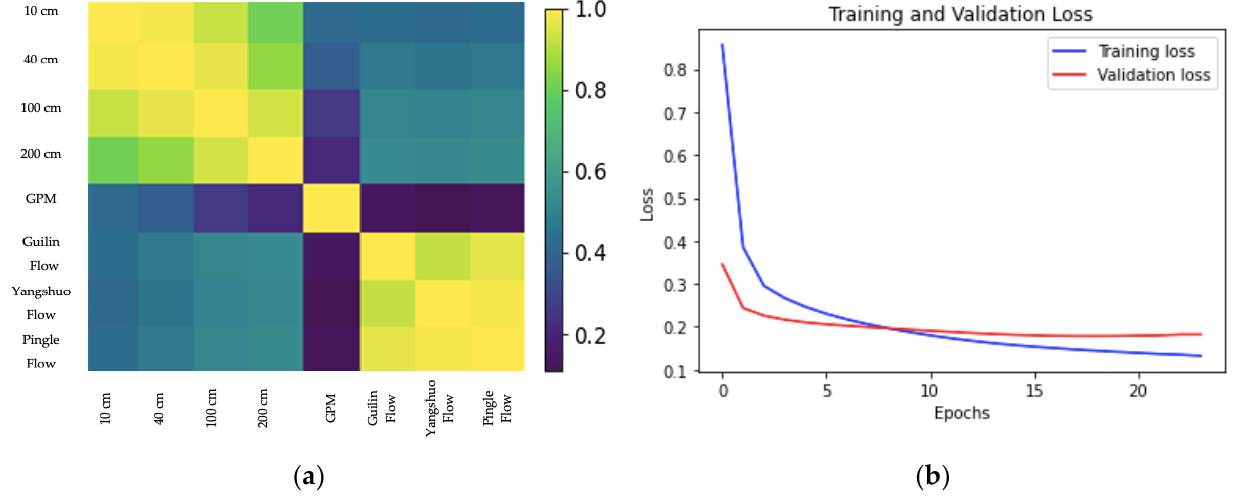
Figure 8. ( a ) Feature correlation heatmap of the eight parameters via LSTM, darker colors show significant correlation. ( b ) Training and validation loss errors of the algorithm.